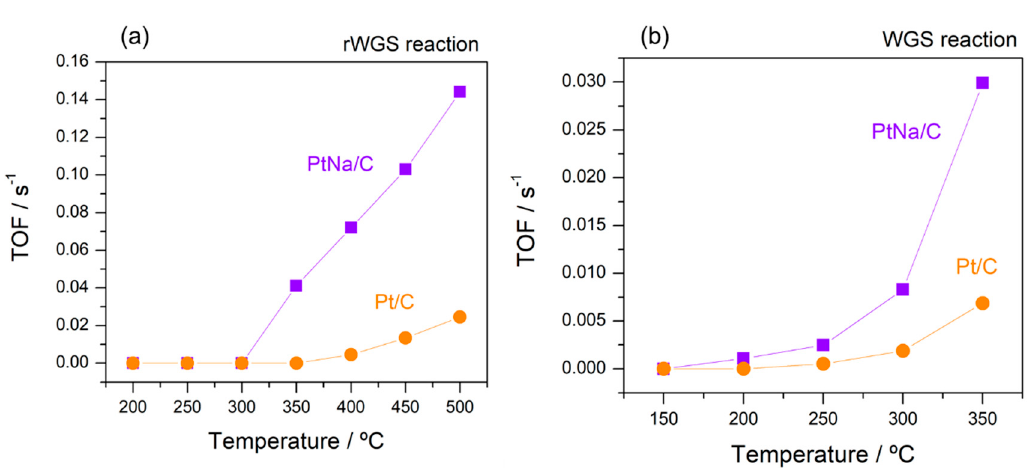
Figure 9. TOF plots of intrinsic reaction rates of ( a ) rWGS and ( b ) WGS measured for both catalysts. Arrhenius plots for estimating the apparent activation energy in the reverse and the forward WGS reaction are plotted in Figure 10. The obtained values of activation energy for WGS and rWGS reaction are in good agreement with the experimental and theoretical values reported for supported Pt-based catalysts [9,15,41,49]. The apparent activation energy in WGS reaction estimated by Zhai et al. [13] presented a 15 kJ mol − 1 decrease on the Na-promoted catalyst with respect to their Pt/Al 2 O 3